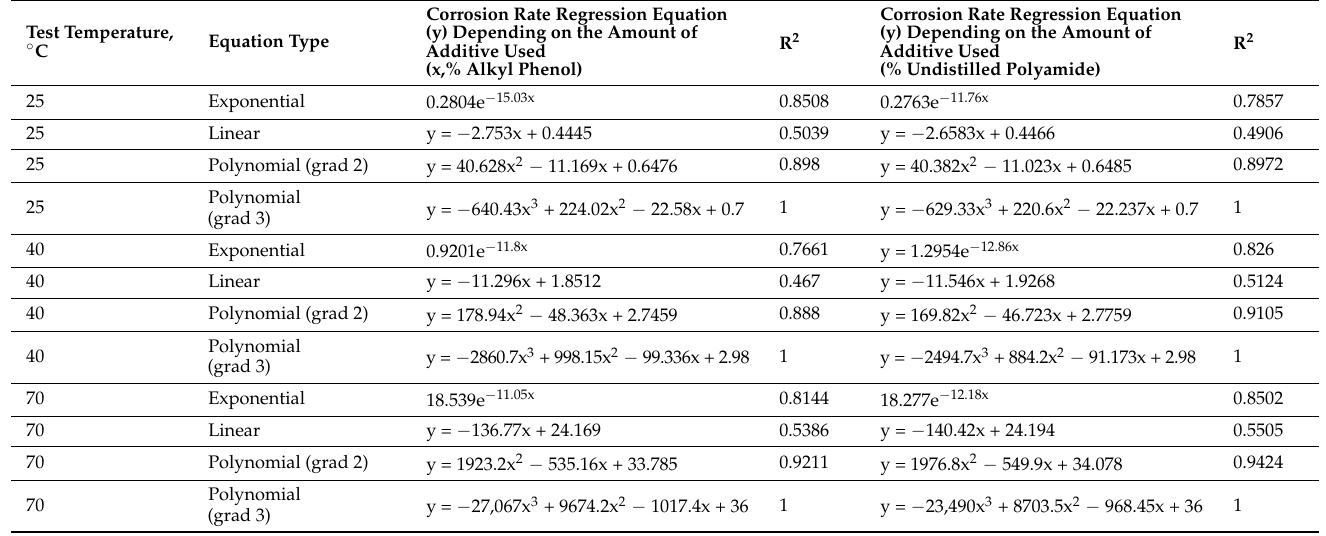
Table 9. Corrosion rate equations (y) as a function of temperature, HCl content of the solution (10%), and the amount of antacid additive used